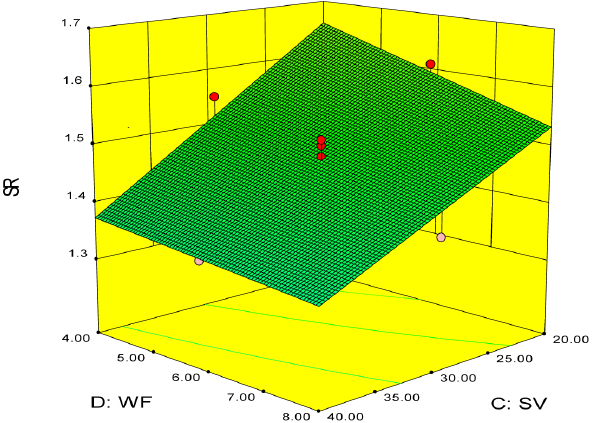
Figure 7c. Combined e ff ects of SV and WF on SR.